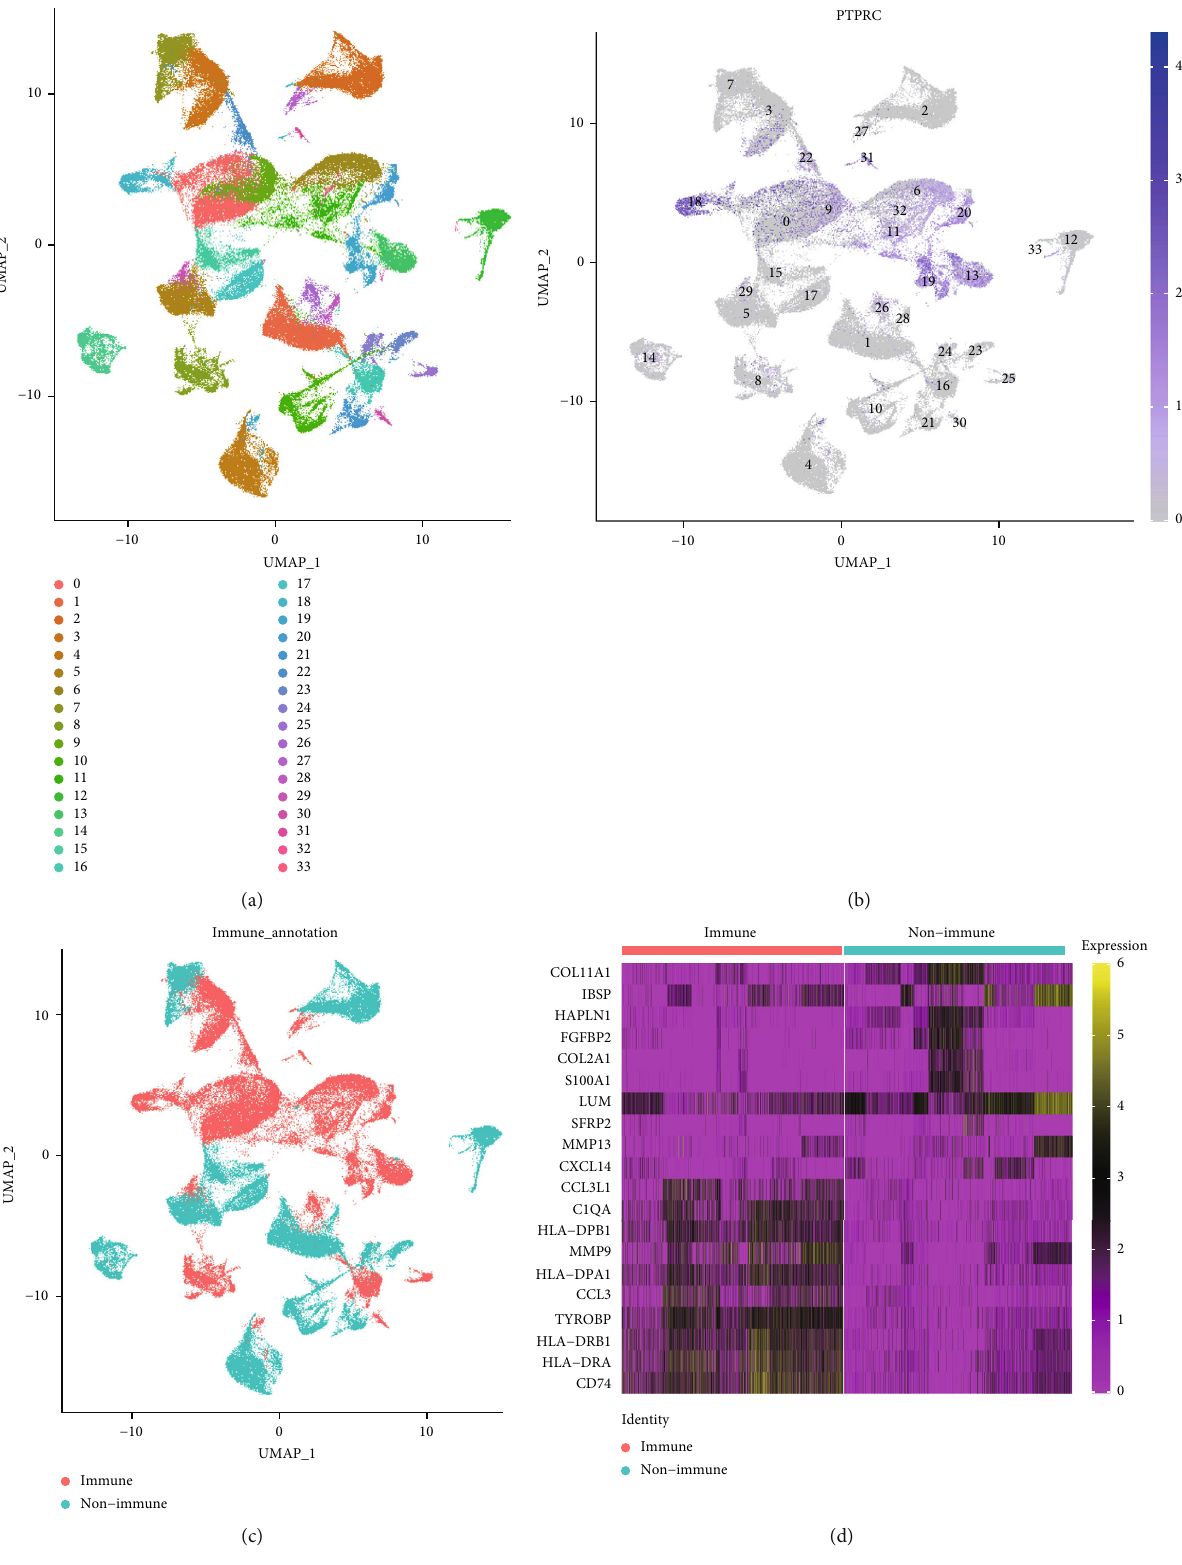
Figure 1: Identi fi cation of cell types in OS scRNA-seq sample. (a) UMAP plot of OS scRNA-seq data with 34 clusters ( resolution = 0 : 5 ). (b) Expression of immune marker PTPRC (CD45) across all clusters, shown by UMAP plot. (c) Clustering of OS tissue via immune markers to obtain immune and nonimmune cells. (d) Heatmap of marker gene expression levels in di ff erent